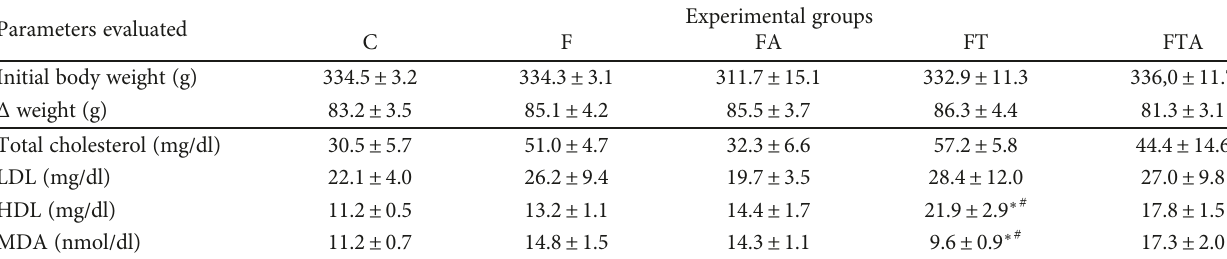
Table 2: Evaluation of body weight, lipids, and MDA serum